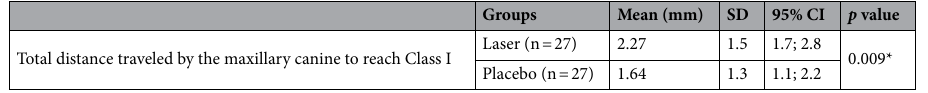
Table 3. Mean displacement of the maxillary canine to Class I in the two groups. mm millimeters, SD standard deviation, 95% CI 95% confidence interval; *Indicates significant differences between the groups.